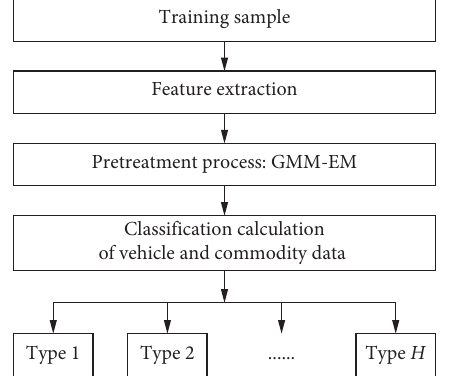
Figure 3: Schematic diagram of GMM-EM for